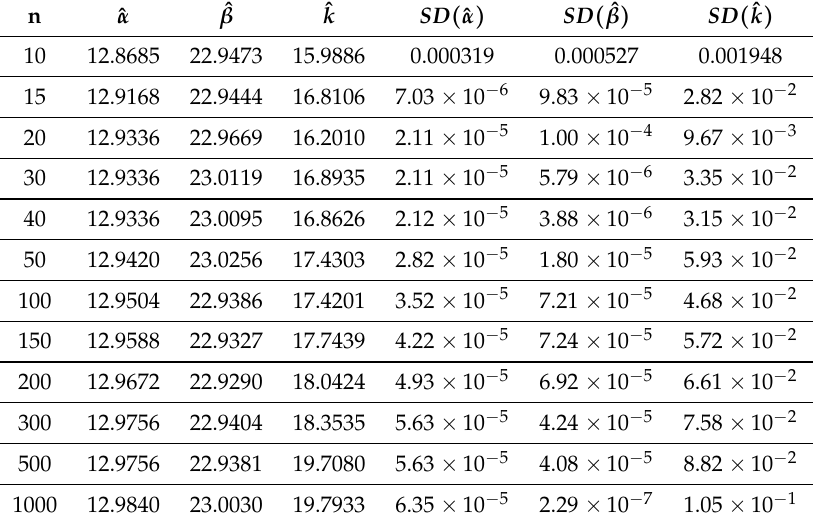
Table 12. Results of simulation with samples of censored data using the gradient method with m = 10,000, α = 13, β = 23, k = 18, θ = 0.15. n ˆ